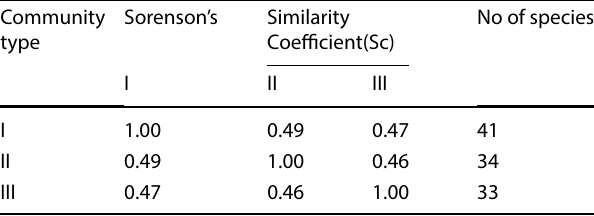
Table 3 Sorenson’s similarity coefficient among the three commu- nity